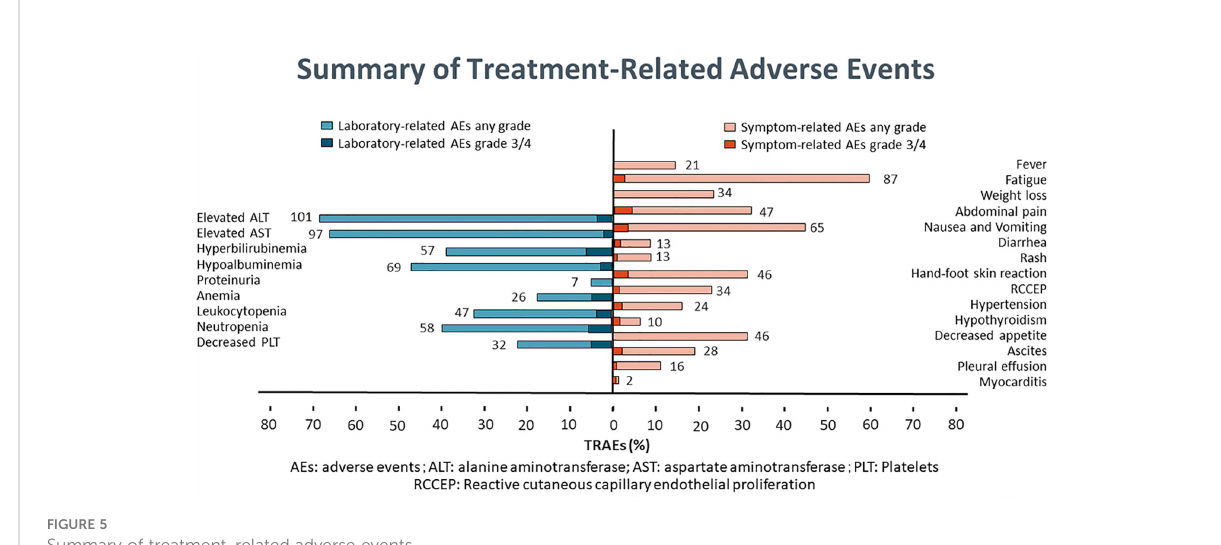
FIGURE 5 Summary of treatment-related adverse events.